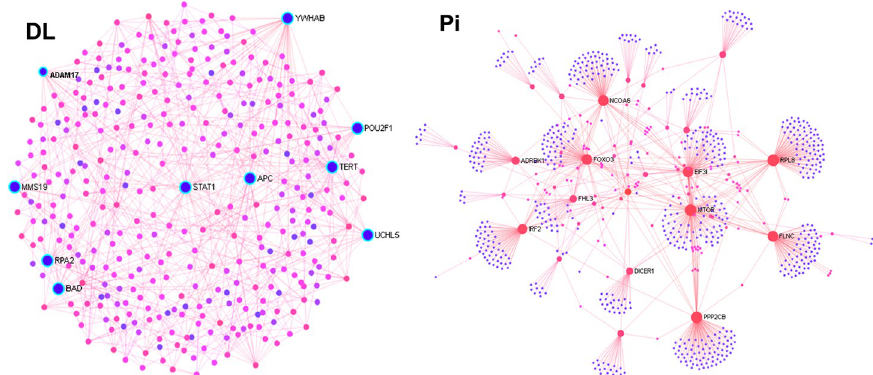
Fig 5. Network of breed-specific altered transcriptome in PBMCs after PRRSV vaccination. The network DL- specific DEGs is on the left panel (indicated by DL) and the Pi-specific transcriptome network is on the right panel (indicated by Pi). The network centrality estimates and relative expression values of major hub genes are provided in Table 2.